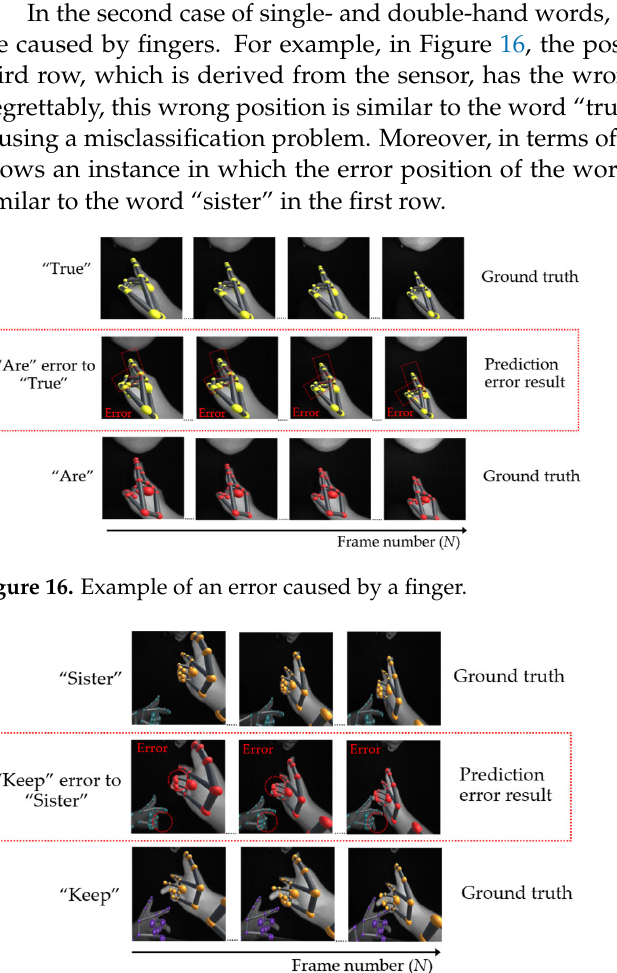
Figure 15. Example of an error caused by the palm.